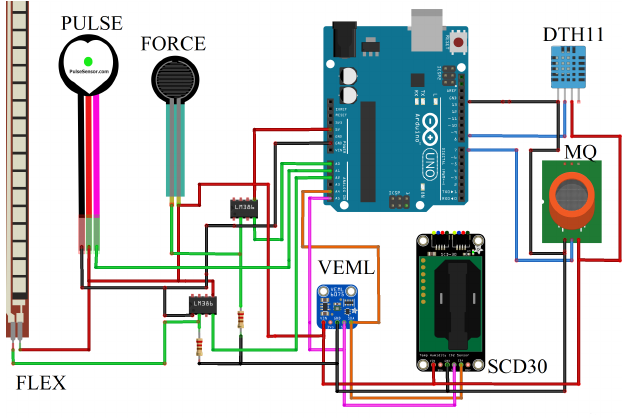
Figure 3. Sensors used in this work according to the new proposed taxonomy. ( — ) Analog connection, ( — ) Digital connection, ( — ) Prot. Communication connection (SDA), ( — ) Prot. Communication connection (SCL), ( — ) VCC, ( — ) GND.